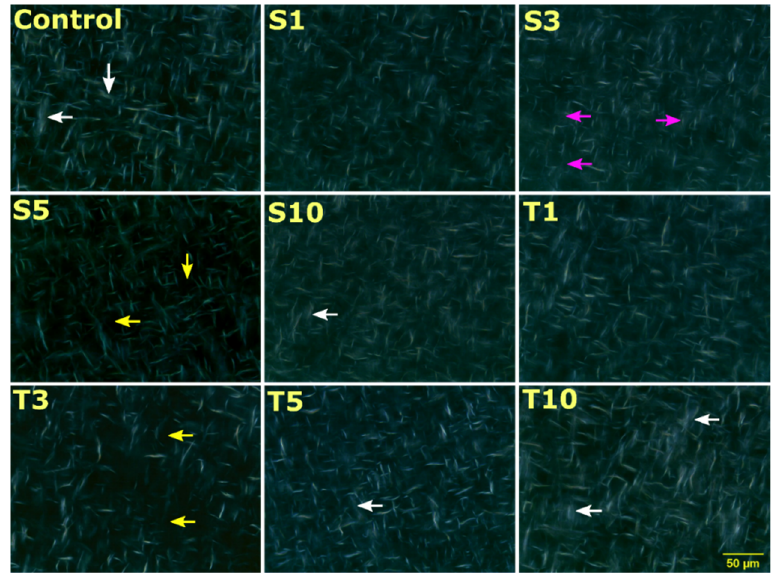
Figure 5. Polarized light micrographs of oleogel formulations. The details of abbreviations used are provided in Section 4.2 (Table 5).